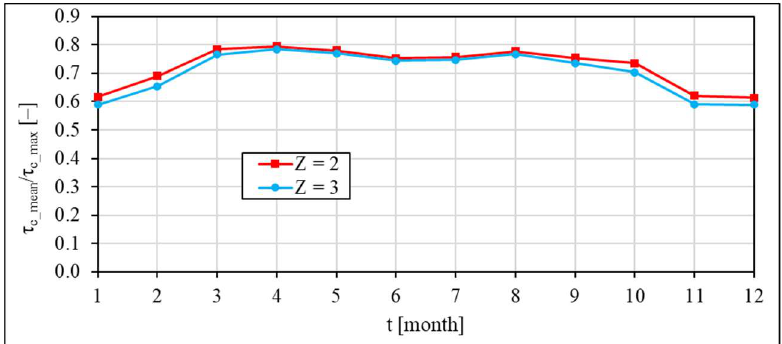
Figure 10. Ratio of mean twenty-four-hour to maximal values of TST for characteristic days of the year (solar ray reflections from two surface or three surface polycarbonate channels).